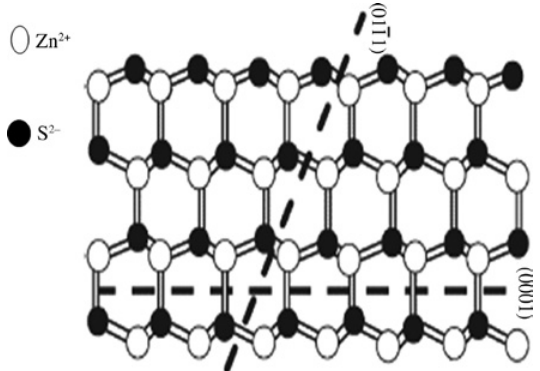
Figure 2: ZnS wurtzite polar crystalline nanostructure projected along [1210] (Reprinted with permission from Ref. [31], copyright 2006 by the Royal Society of Chemistry).